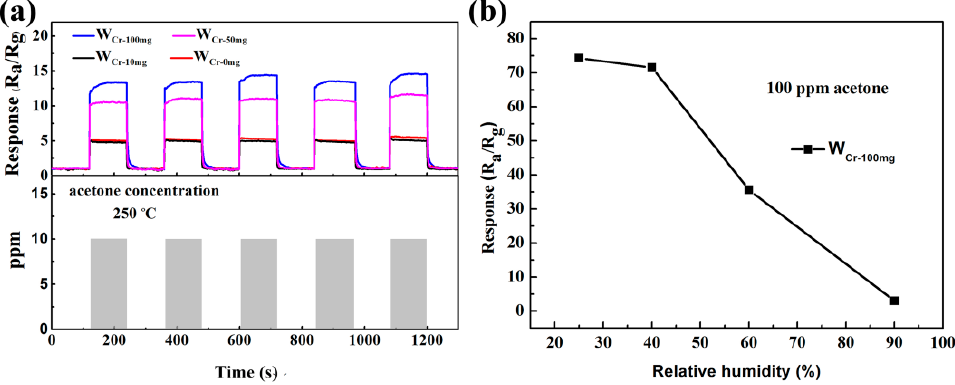
Figure 11. ( a ) Five cycles of response of W Cr-0mg , W Cr-10mg , W Cr-50mg and W Cr-100mg gas sensors towards 10 ppm acetone at 250 °C, and ( b ) the corresponding responses to different relative humidities (%) for W Cr-100mg sensors.